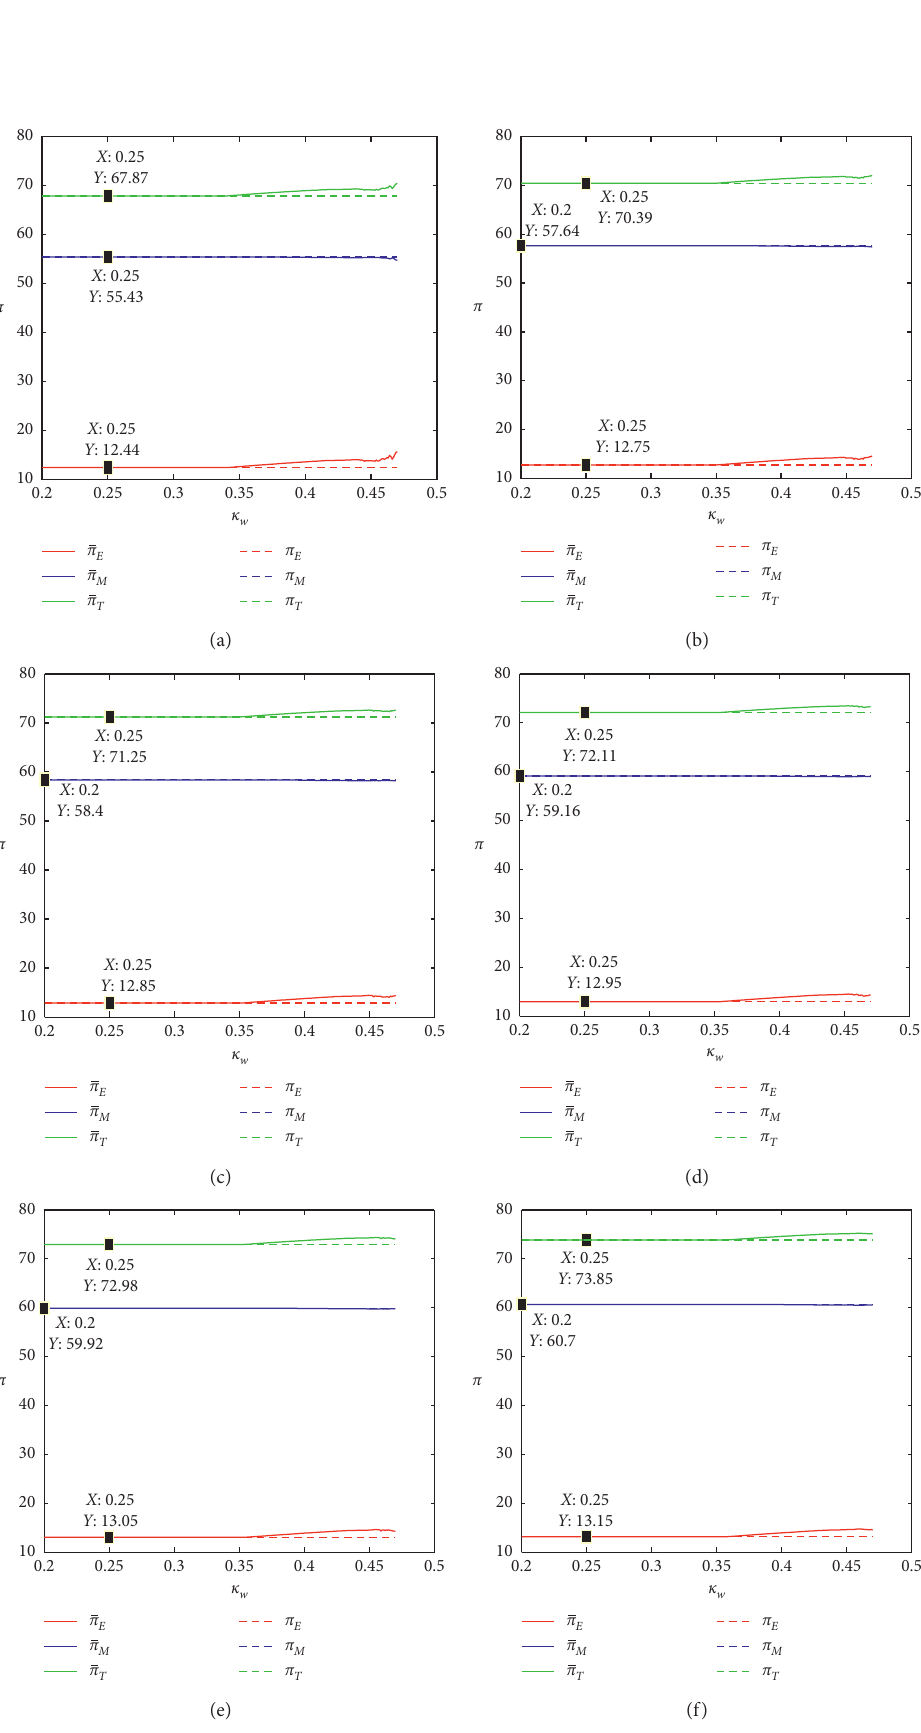
� − 0 . 4. (b) τ � − 0 . 1. (c) τ � 0. (d) τ � 0 . 1. (e) τ � 0 . 2. w under different τ . (a) τ